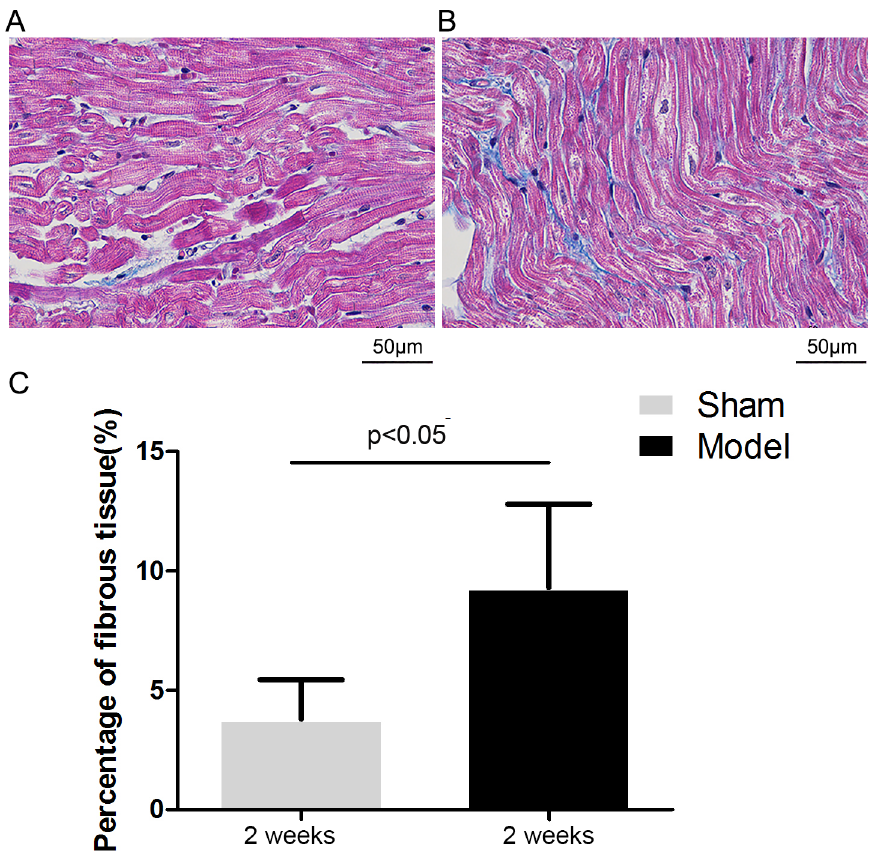
Figure 8. Analysis of atrial fibrosis. Representive images of Masson staining of the left atrial tissue after 2 weeks of interventional operation in the sham (A) and model groups (B). Mean percentage of interstitial fibrosis of the left atrium (C).